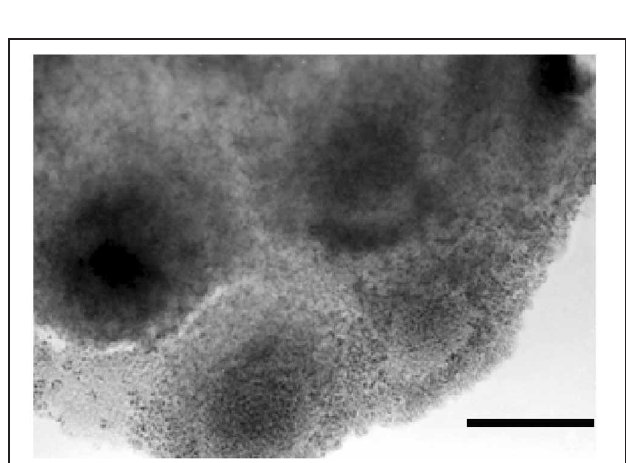
FIGURE 6 | AChE activity (arrows) (Karnovsky and Roots, 1964) in the Hensen’s node of a 24h chick embryo (A), and in the chord and neural floor plate (empty arrow) along further development (B,C). fp, loor plate; ch, chord. Bars equal 100 μ m.